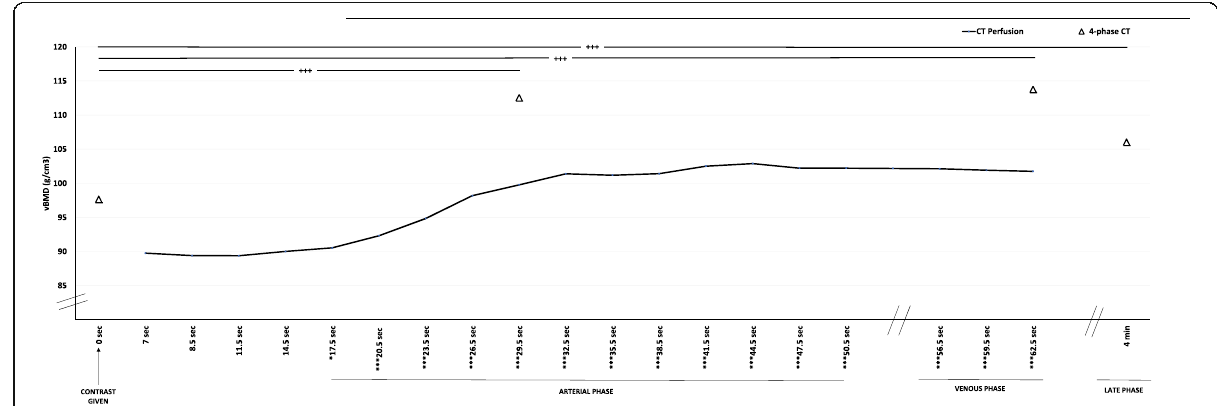
Fig. 3 Volume bone mineral density (vBMD) over time in computed tomography (CT) perfusion imaging (CTPI) examination (black line) and 4- phase CT examination (triangles). In CTPI, statistically higher vBMD values were found for all time-points after 17.5 s (* in label of x -axis) compared to reference value at 7 s (unenhanced phase in vertebrae). Similar significant differences were observed for 4-phase CT where the arterial, venous, and late venous phase had significantly higher vBMD estimations than the unenhanced phase (+). */+ indicates p < 0.05, **/++ indicates p < 0.01, and ***/+++ indicates p <